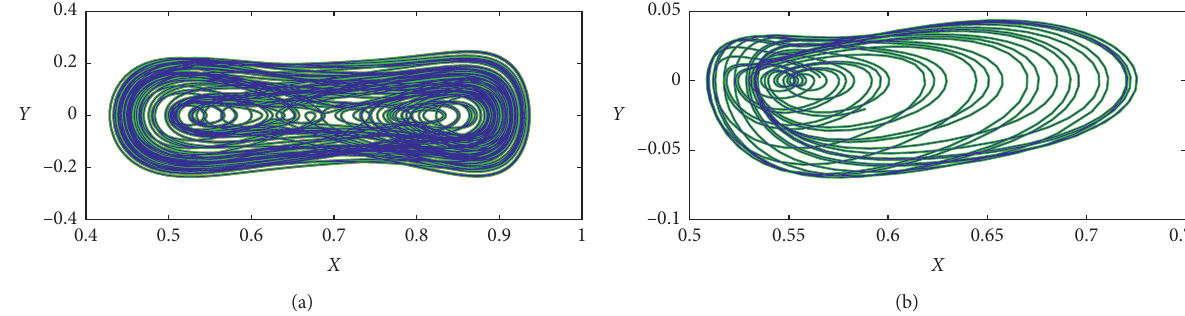
Figure 2: Phase portrait of system (7): for (a) η � 0 . 1 and initial condition [0.6, 0] chaotic attractor and for (b) η � 1 . 5 and initial condition [0.5, 2] attracting tori.